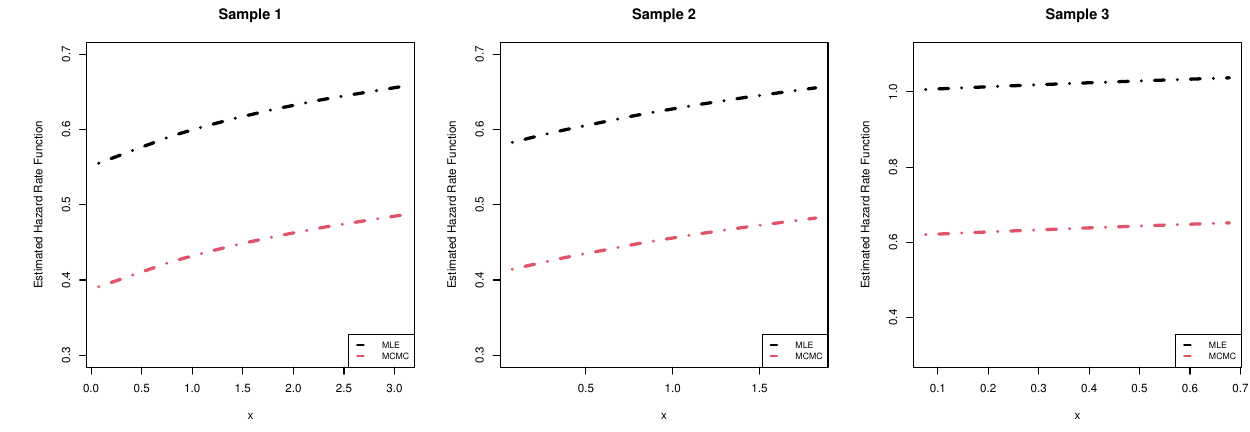
Figure 11. Estimated hazard rate plots from the SSB data.